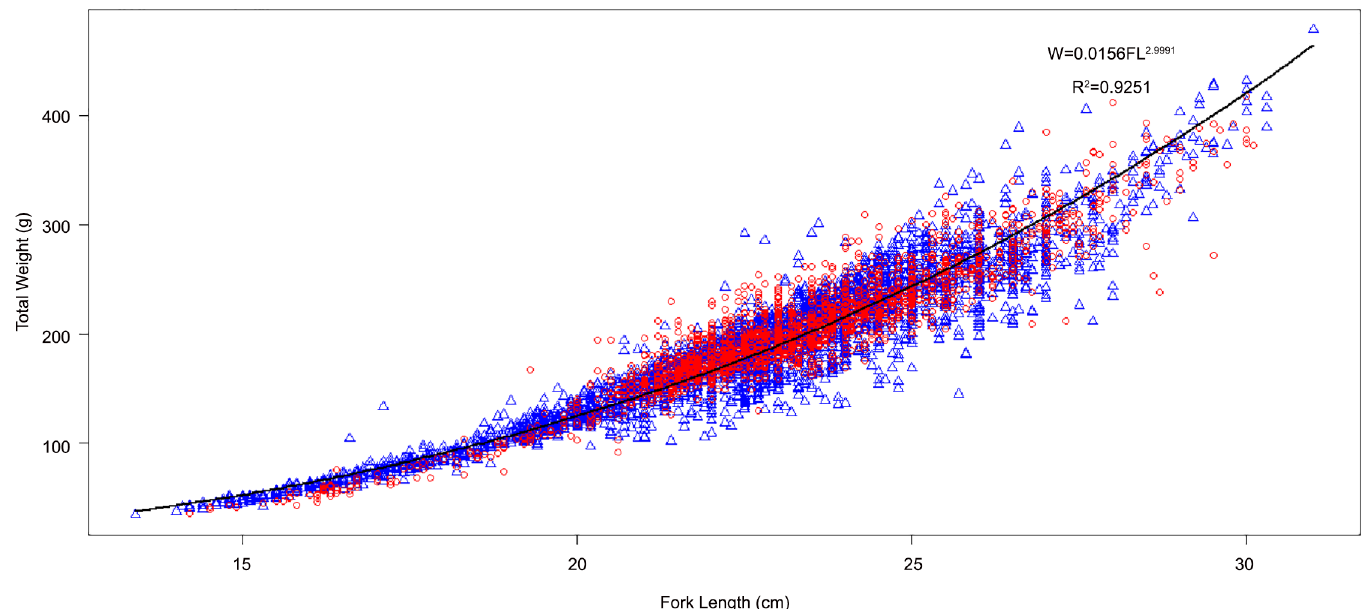
Fig 2. Length-weight relationships for Sardinella maderensis in Senegalese waters. Blue triangles and red dots represent the length-weight relationships during the cold season and hot season, respectively. The black line is the model fitted to all measurements regardless of season.